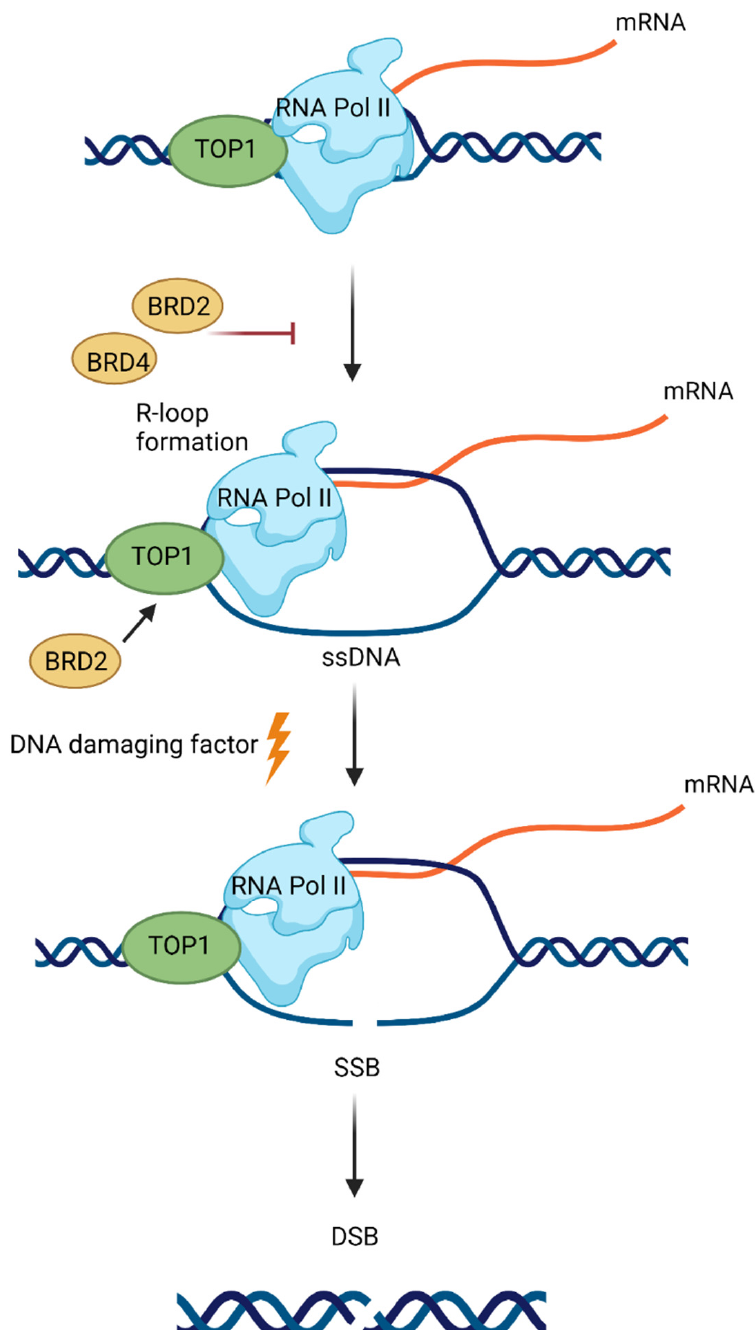
Figure 4. Bromodomain and extraterminal domain 2 and 4 (BRD2 and BRD4) proteins prevent DNA damage induction at the sites of RNA polymerase II (RNA Pol II) activity. BRD2 and BRD4 restrict the formation of transcription-associated DNA:RNA hybrids (R-loops). Topoisomerase I (TOP1) activity, a known restrainer of R-loops, is promoted by BRD2. R-loop formation leads to the exposure of a single-strand DNA (ssDNA) on the nontemplate strand to DNA damaging factors. This can result in the induction of single-stranded breaks (SSBs), which can be converted to double-stranded breaks (DSBs).